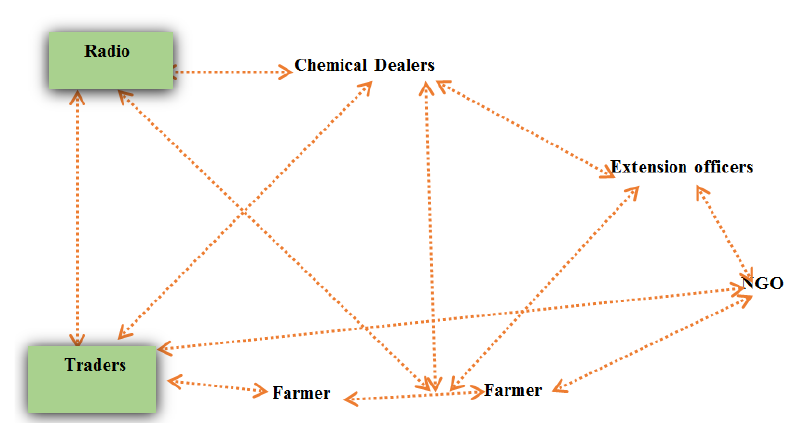
Fig. 1. Authors’ blend of the agricultural information sources noted in the Literature